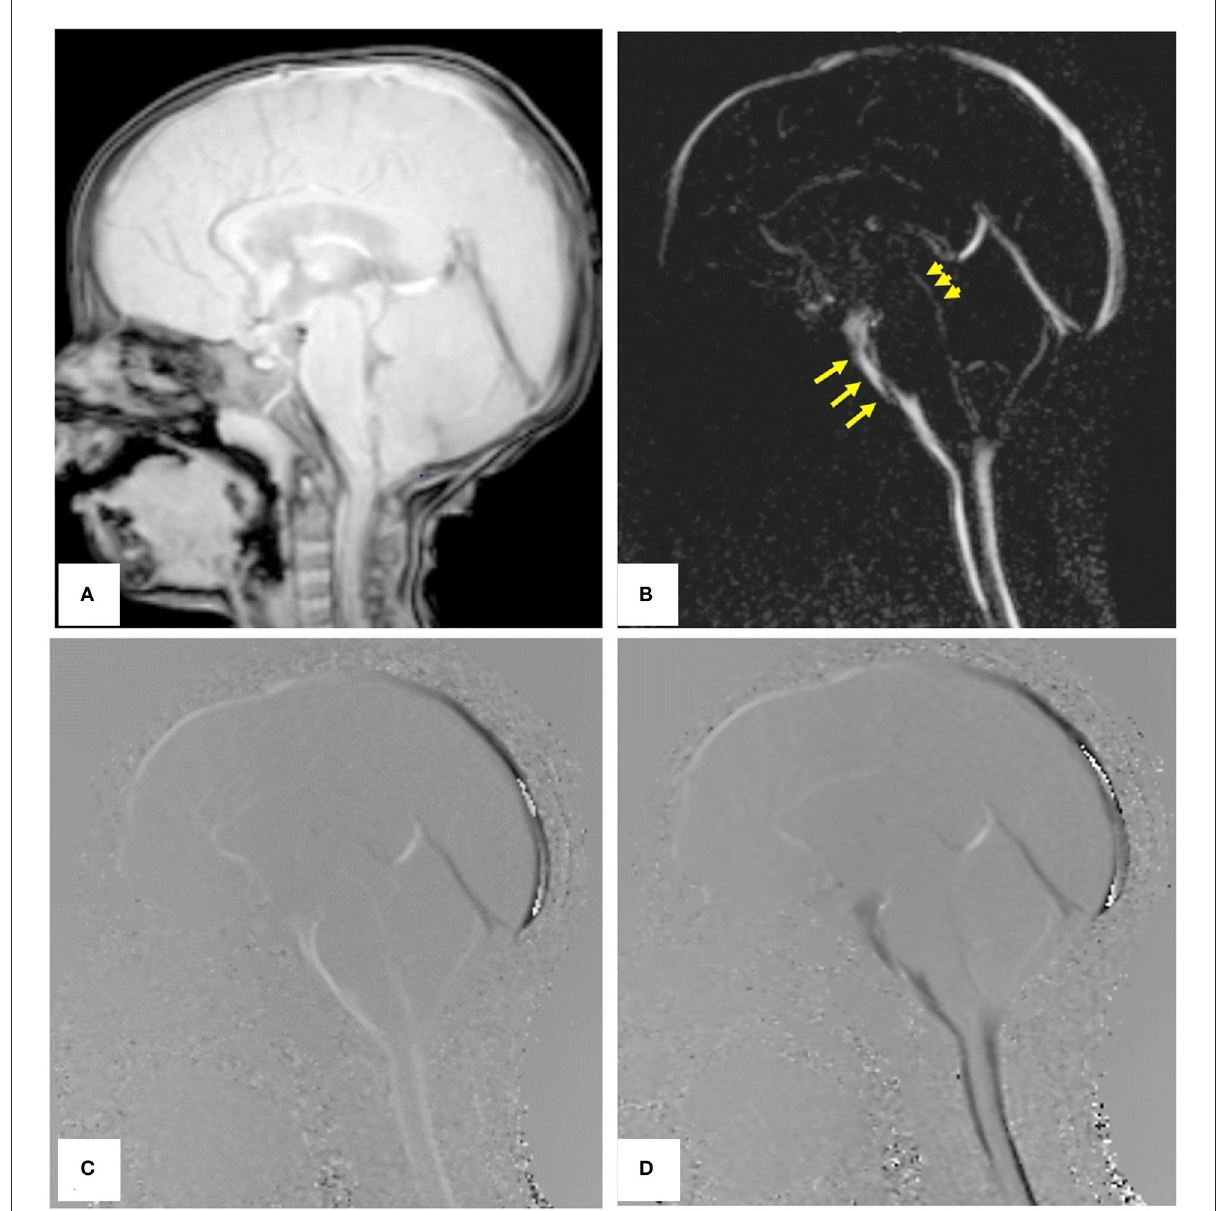
FIGURE6 PCMRI image of a subject in the sagittal plane. (A) Re-phased image to show the background. (B) Magnitude image in which the flow is bright. (C,D) Are phase images showing the oscillation of CSF flow with bright and black color throughout the cardiac cycle [Reproduced from Mohammad et al. (67) with